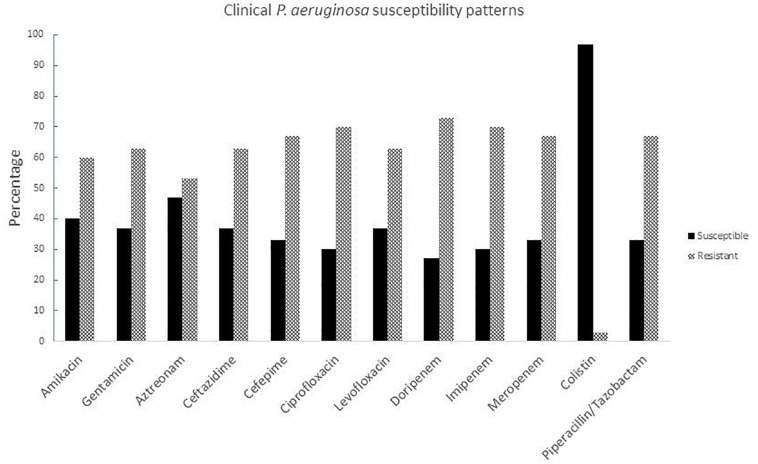
Susceptibility patterns of clinical P. aeruginosa strains isolated from burned patients.